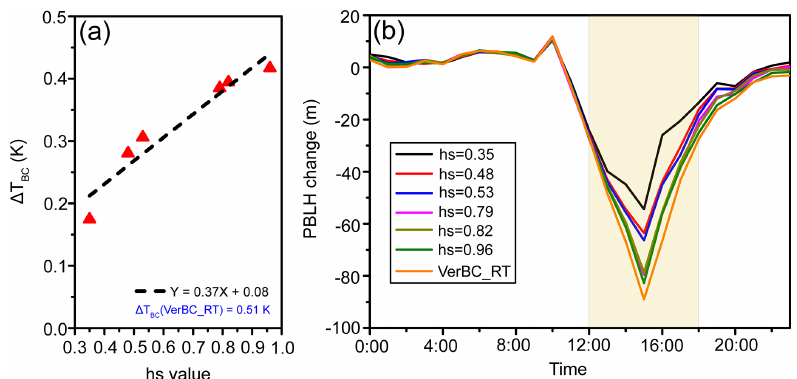
Figure 13. (a) Variation in (cid:49)T BC caused by BC DRE with increasing hs values averaged for 12 and 16–19 December. The black dashed line is the linear fit. (b) Time series of changes in PBLH in Beijing caused by different BC vertical profiles averaged for 12 and 16–19 December 2016.